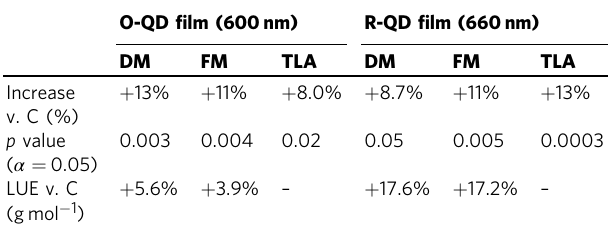
Table 2 Percentage differences and signi fi cance of effect sizes, and calculated lighting-use ef fi ciency (LUE) of O-QD and R-QD Films compared with Control